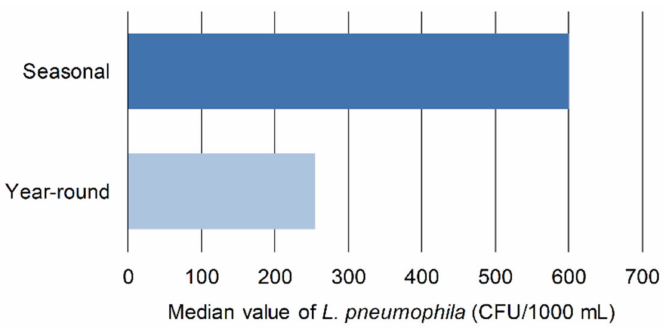
Figure 4. Median of Legionella concentration (CFU/1000 mL) by year-round vs. seasonal facilities. Table 2 shows the values of the analyzed parameters and characteristics of all four